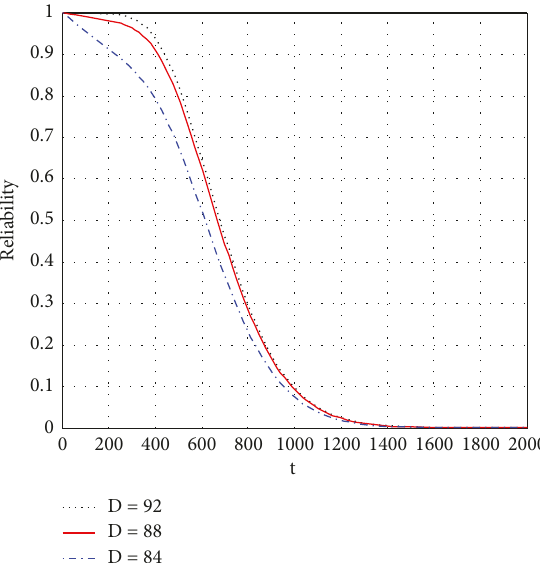
Figure 18: Sensitivity analysis of R ( t ) on D .